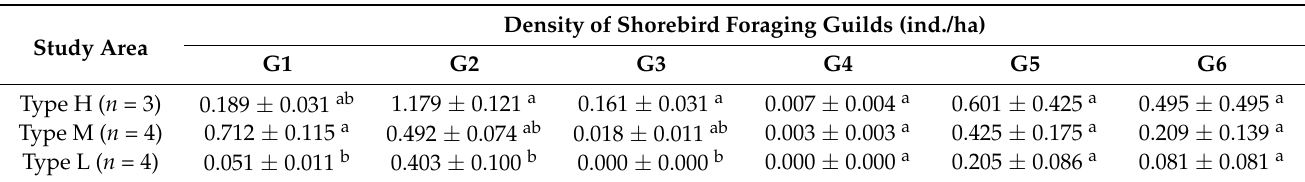
Figure 4. Dendrogram using the average linkage (within groups) with the principal component scores of shorebirds. The shorebird name abbreviations are shown below. AVO: Recurvirostra avosetta ; VAN: Vanellus vanellus ; CIN: Vanellus cinereus ; SQU: Pluvialis squatarola ; DUB: Charadrius dubius ; ALE: Charadrius alexandrinus ; GAL: Gallinago gallinago ; STE: Gallinago stenura ; ARQ: Numenius arquata ; ERY: Tringa erythropus ; NEB: Tringa nebularia ; OCH: Tringa ochropus ; HYP: Actitis hypoleucos ; ALP: Calidris alpina ; TOT: Tringa totanu . Table 5. Density (ind./ha) of shorebird foraging guilds in the different study areas. Density of Shorebird Foraging Guilds (ind./ha) Study Area